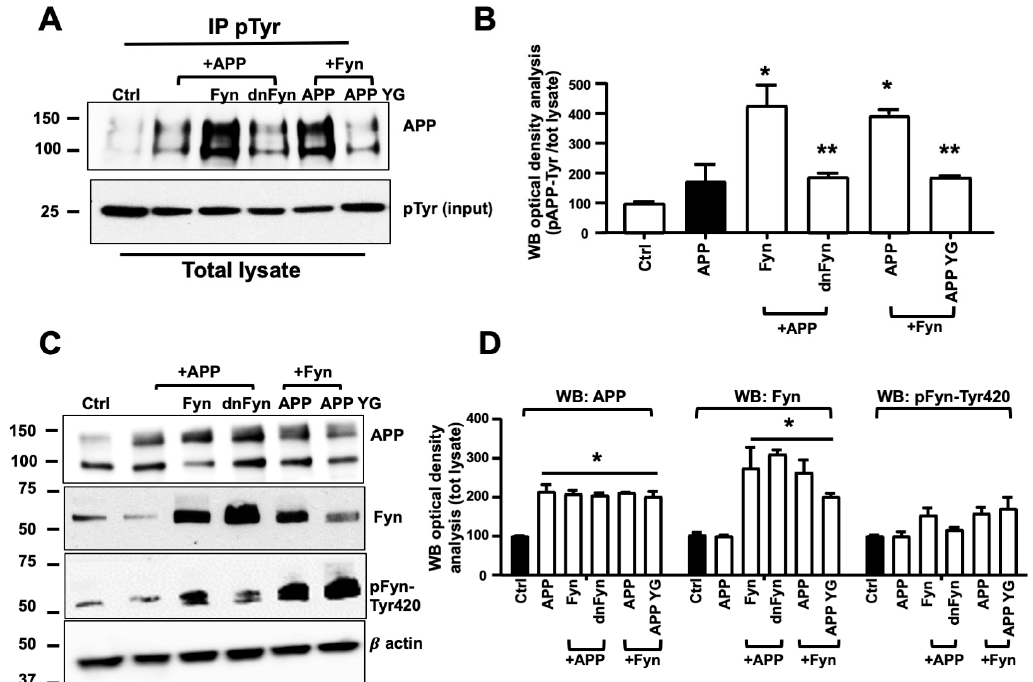
Figure 2. Fyn triggered APP phosphorylation at Tyr682 in human neurons. ( A ) Untransfected control neurons (Ctrl) and APP, APP + Fyn, APP + dnFyn, and APP YG + Fyn were immunoprecipitated with mouse anti-pTyr magnetic beads and analyzed by WB with rabbit anti-APP antibody. WB